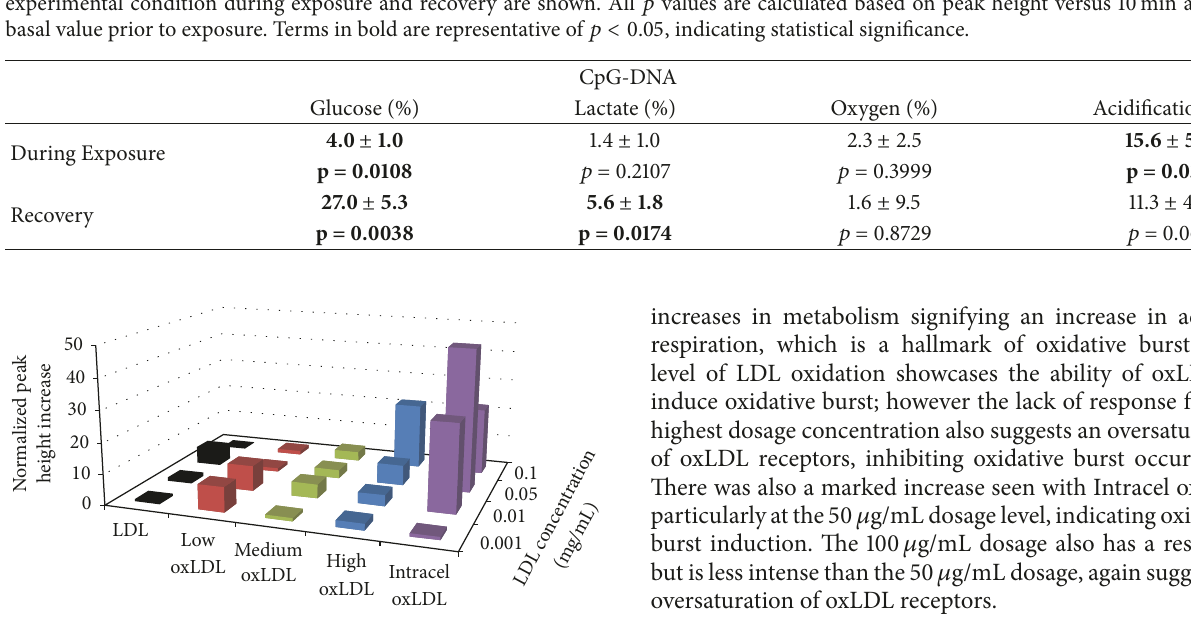
Figure 4: Average extracellular acidification responseof RAW 264.7 cells to a 6min exposure of various LDL. Percent increases were calculated based on the variation from the maximum peak height chance during exposure to the baseline average, prior to